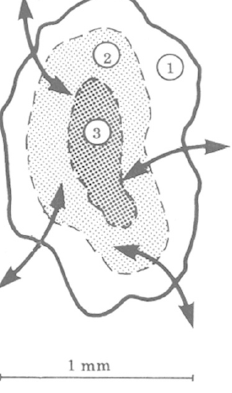
Figure 4. Zonation in a 1-millimeter-wide ellipsoidal fecal pellet. 1: transit sector; 2: mineralogenesis sector; 3: sector isolated from surrounding environment, after Odin [23].